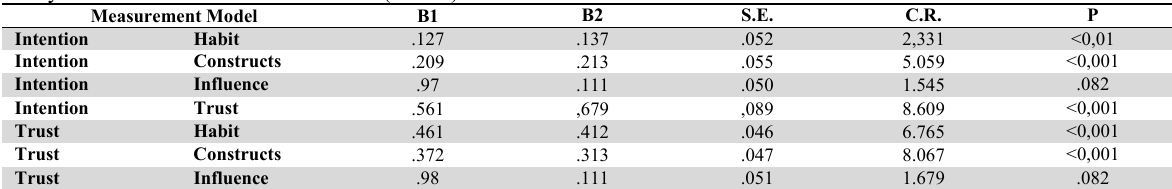
Analysis Results for Structural Model 2